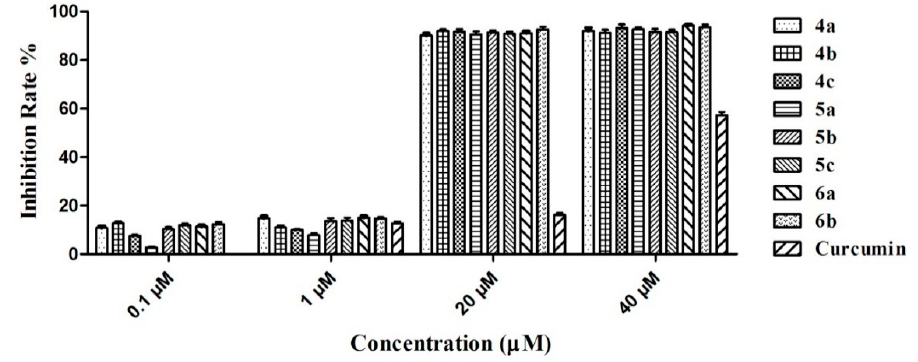
Figure 5. Inhibition for SH-SY5Y of compounds 4a – 4c , 5a – 5c , 6a – 6b and curcumin at different concentrations.